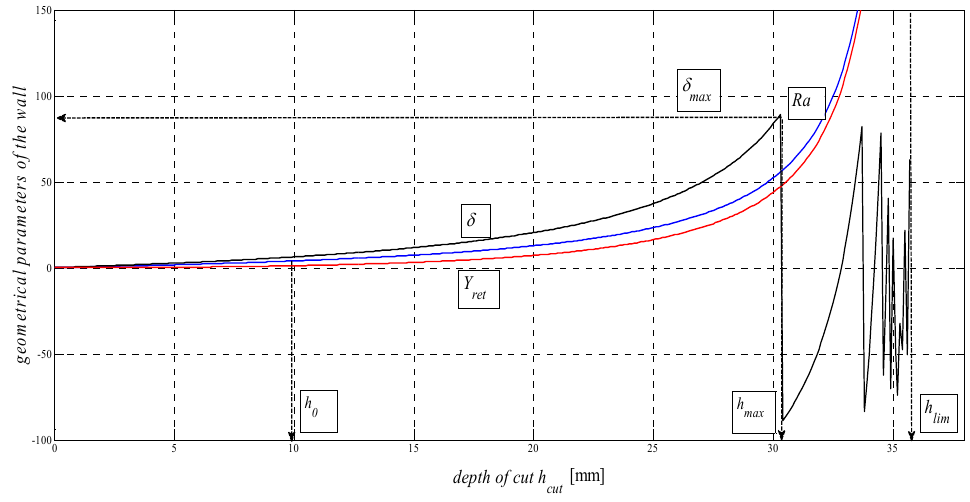
Figure 4. Dependence of main deformation parameters of the surface in the plane containing the cut trace on depth ( Ra , Y ret , δ ) = f ( h cut ) for steel AISI 309 material, E mat = 167.2 GPa.